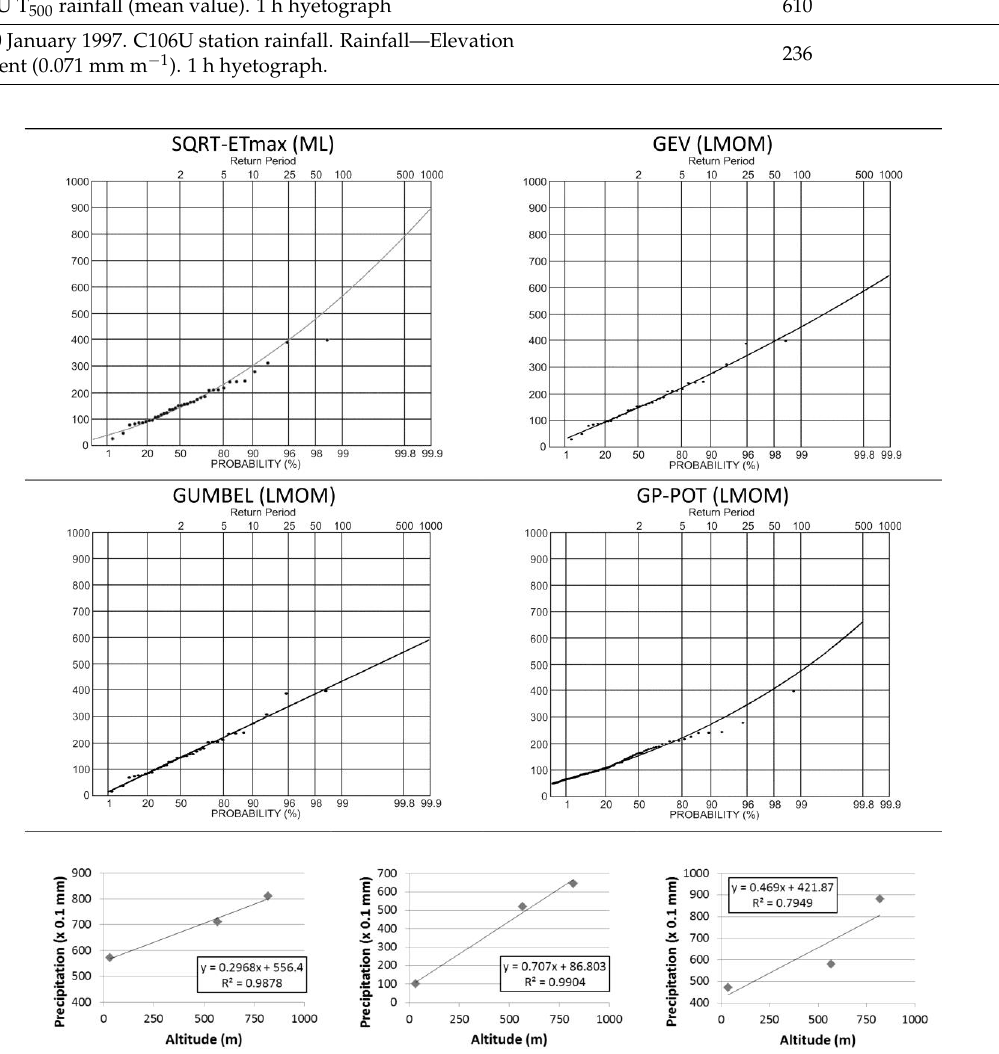
Figure 4. Results of rainfall frequency analysis in the study area and original data plotting positions. SQRT-ETmax, Gumbel and GEV functions were applied to annual maximum data series, while the Generated Pareto (GP) function has been applied to exceedances over threshold data series (POT technique). The linear regression fit for rainfall vs. altitude analysis from rainfall data available is shown at the bottom of the